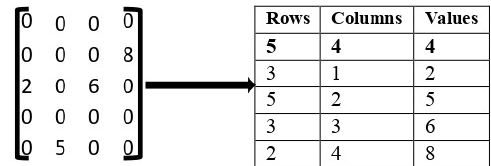
Figure 4. Sparsifying matrix.